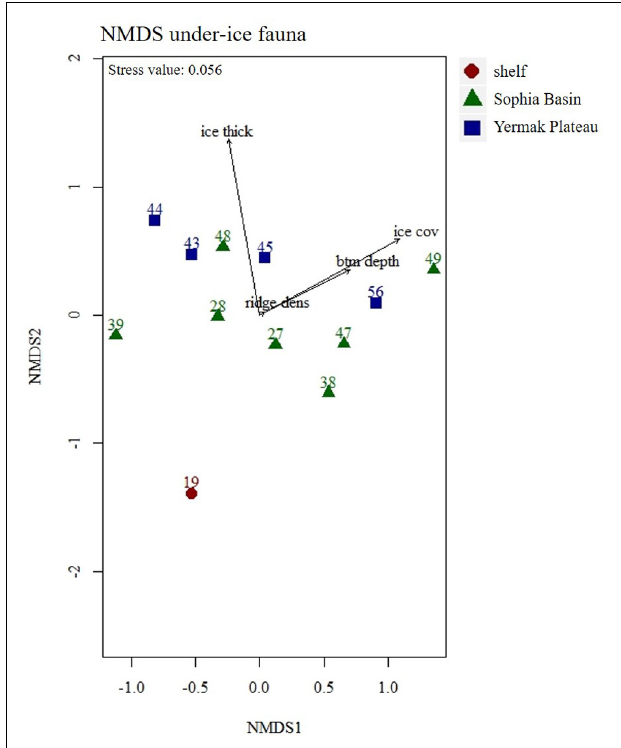
FIGURE 9 | Non-metric Multidimensional Scaling (NMDS) plot of under-ice fauna abundances with four fitted environmental variables. Stations were color coded according to geographical regions (shelf, Sophia Basin, and Yermak Plateau). Ice thick, ice thickness; ice cov, ice coverage; btm depth, bottom depth; ridge dens, ridge